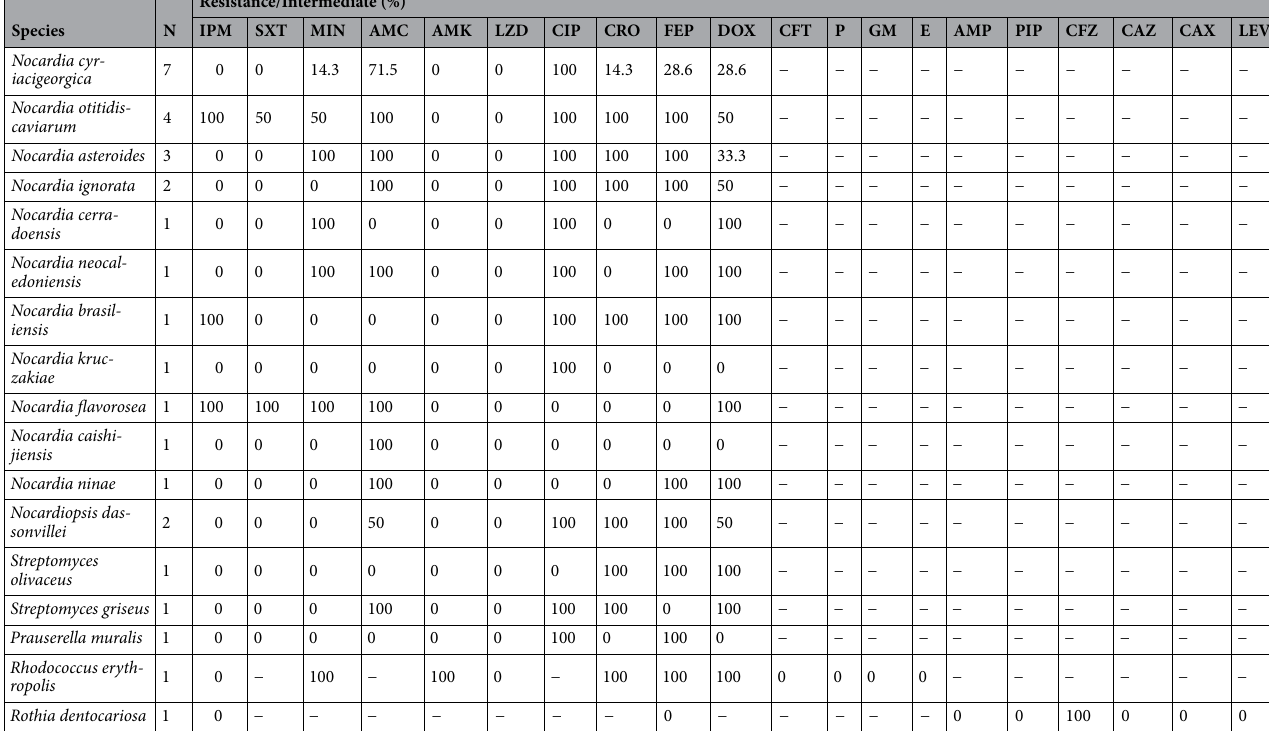
Table 2. Antimicrobial susceptibility pattern of actinomycetes isolates in this study. IPM imipenem, SXT trimethoprim-sulfamethoxazole, MIN minocycline, AMC amoxicillin-clavulanic acid, AMK amikacin, LZD linezolid, CIP ciprofloxacin, CRO ceftriaxone, FEP cefepime, DOX doxycycline, cft cefotaxime, P penicillin, GM gentamicin, E erythromycin, AMP Ampicillin, PIP piperacillin, CFZ cefazolin, CAZ ceftazidime, CAX ceftriaxone, LEVO